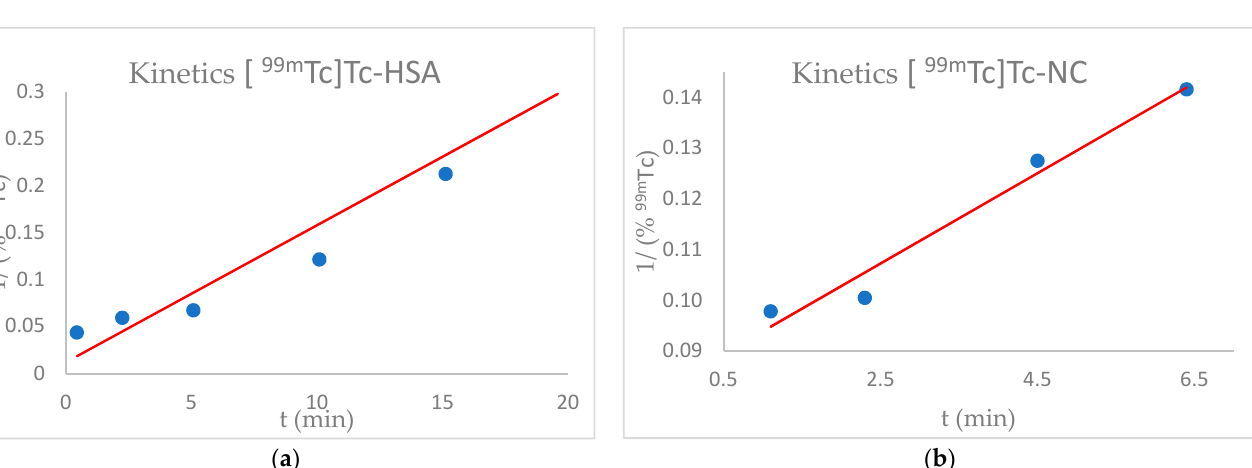
Figure 1. Labelling reaction between [ 99m Tc]Tc and HSA ( a ) or NC ( b ) demonstrate a pseudo-second order reaction.